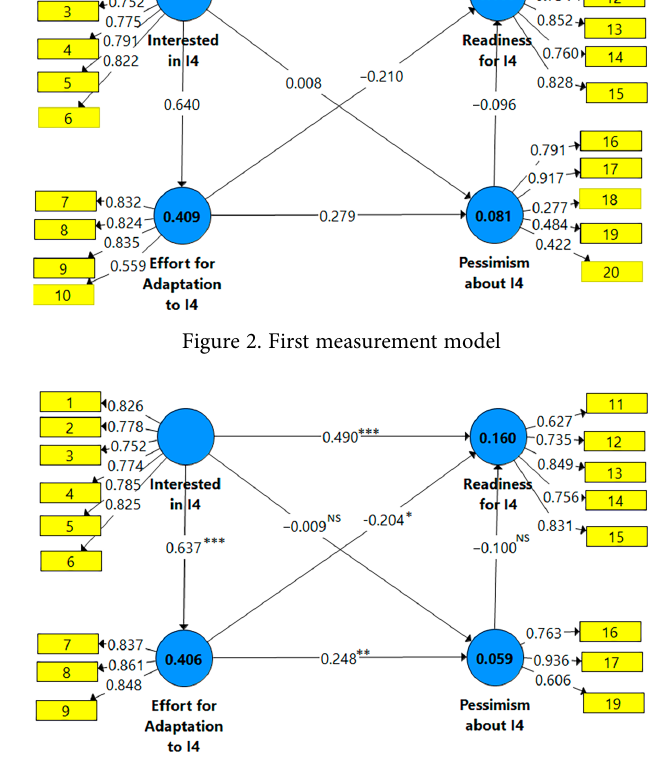
Figure 3. Revised measurement